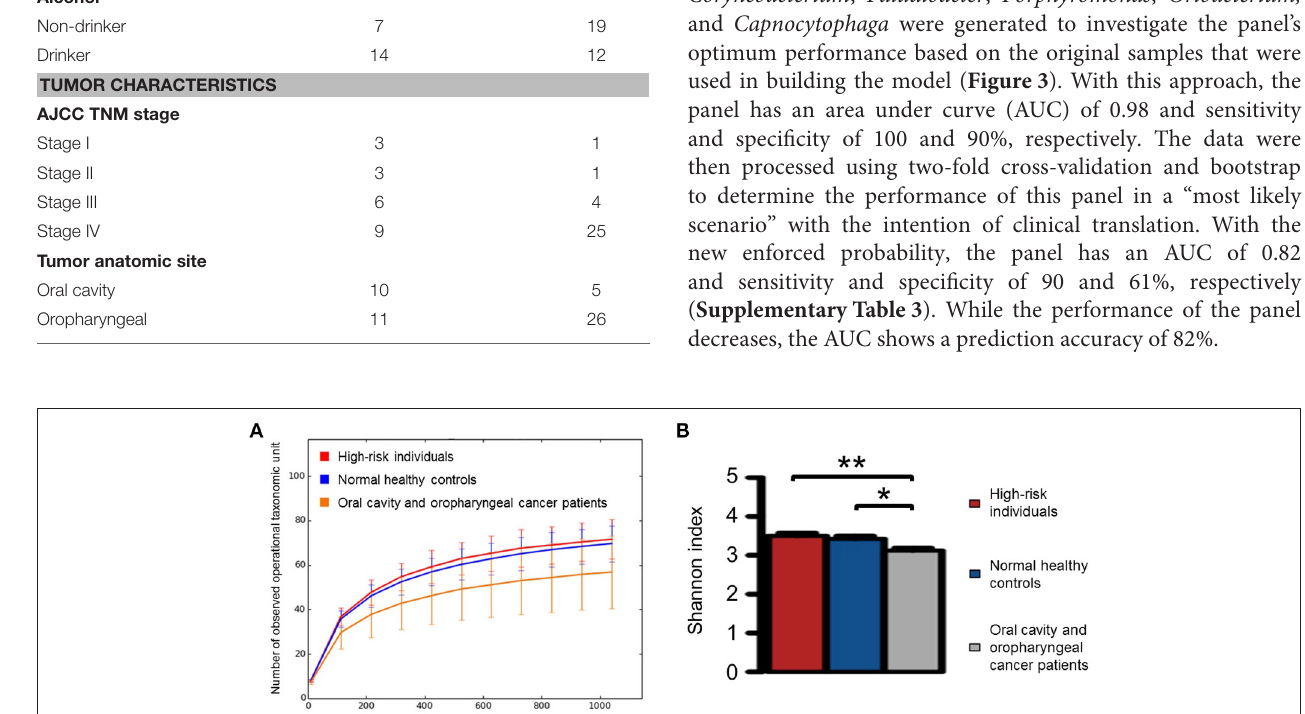
Frontiers in Cellular and Infection Microbiology |